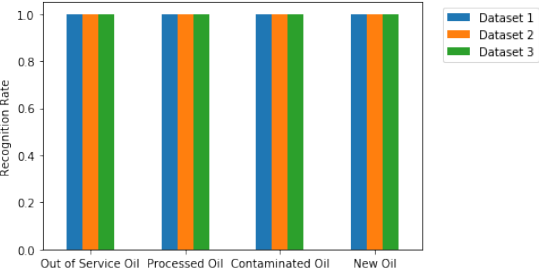
Figure 15. Recognition Rate per Oil and Dataset.